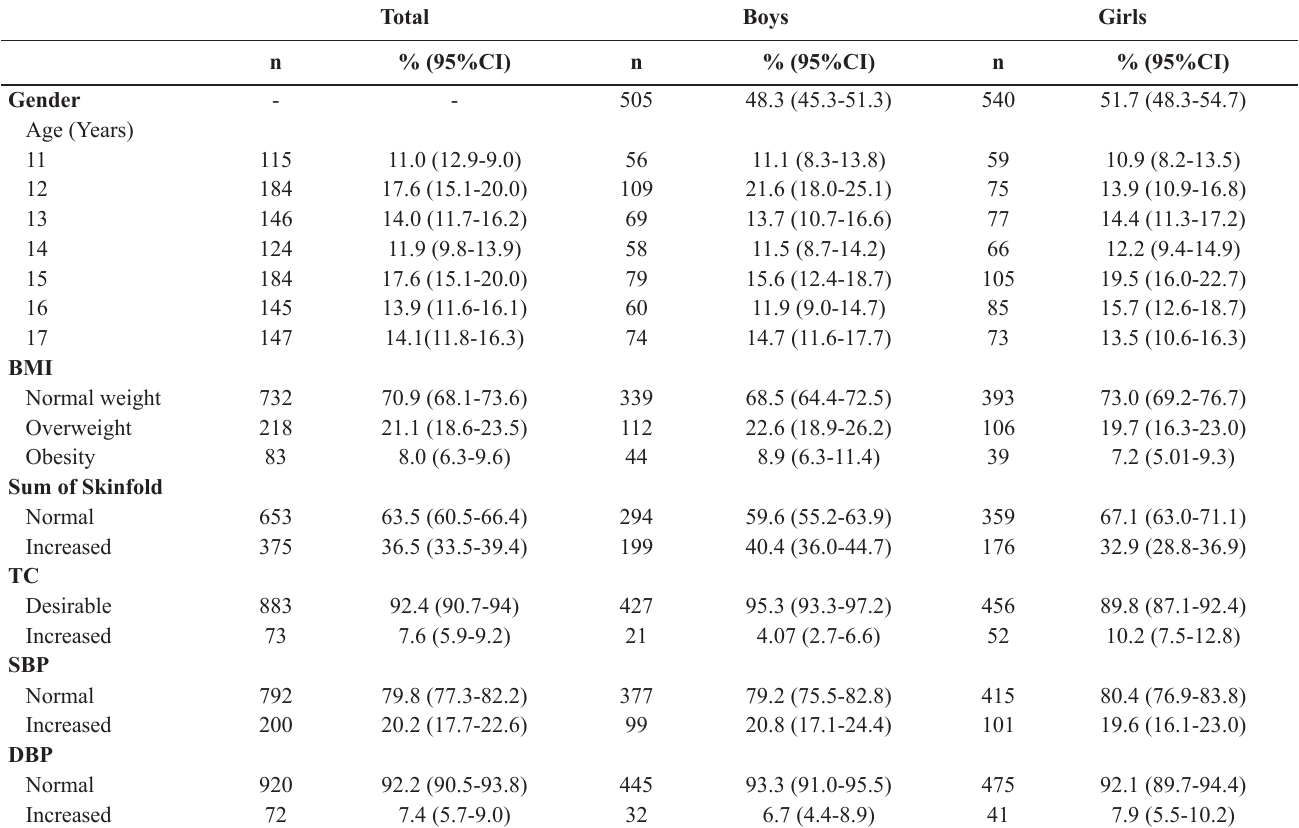
Table 1. Description of the studied variables in adolescents of 11 to 17 years old in Uruguaiana, Rio Grande do Sul State, Brazil, 2012. Total Boys Girls